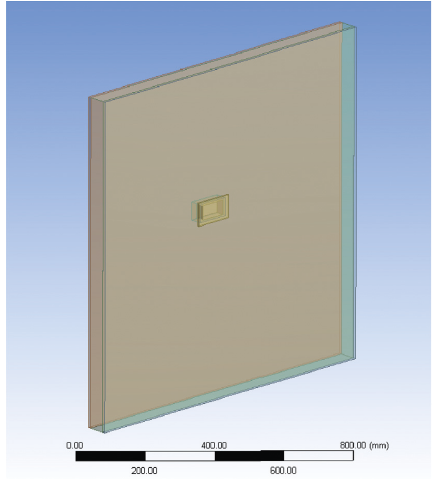
Figure 9: Numerical geometric model of wall embedded with the junction box.